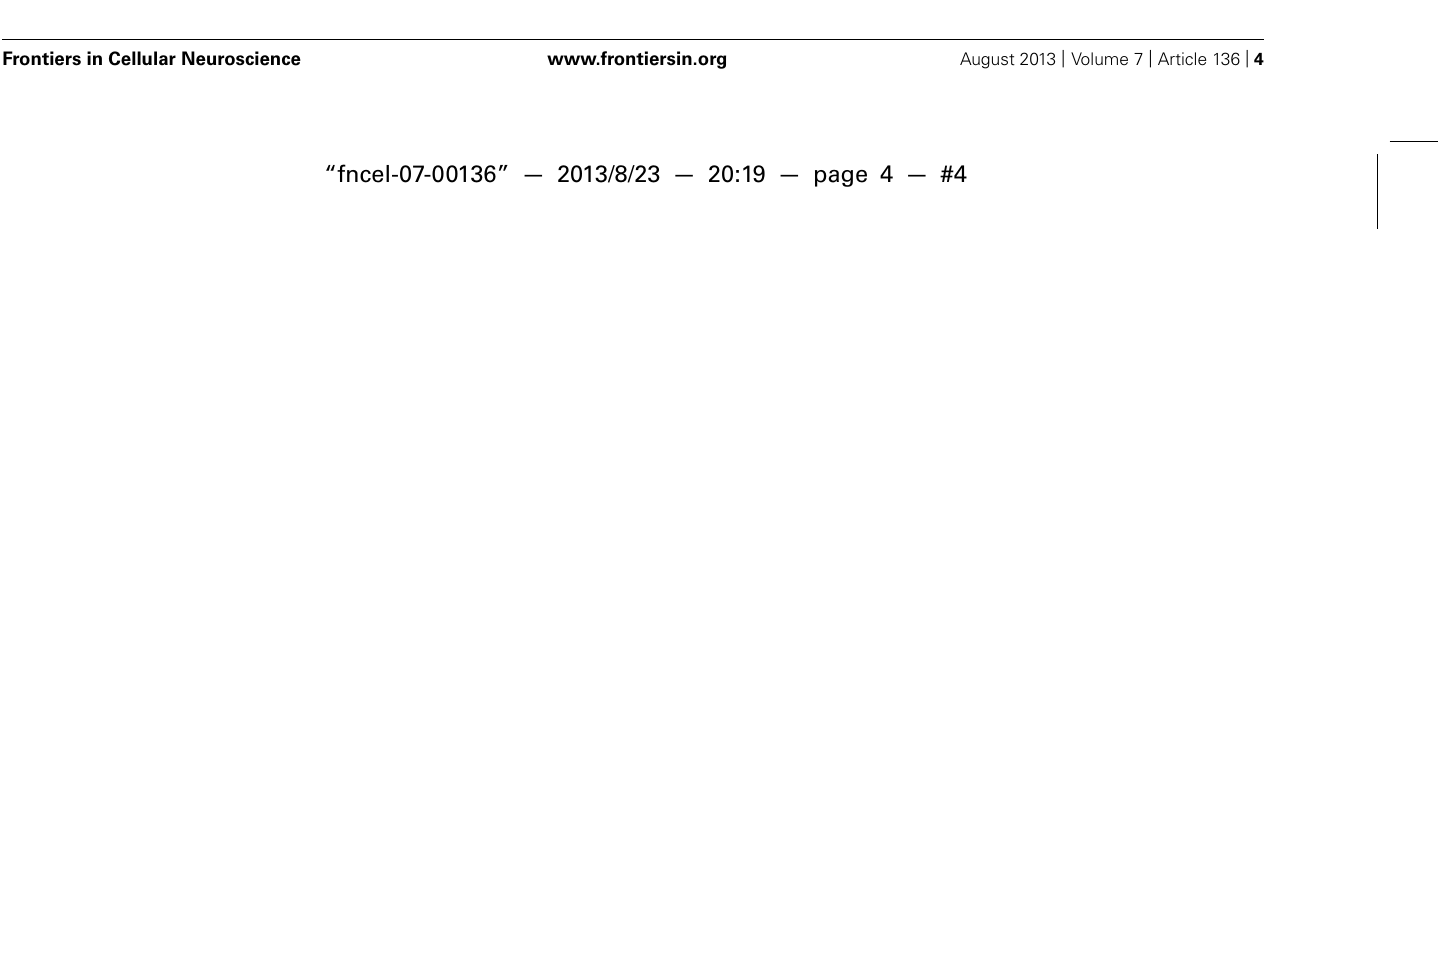
also promotes accelerated miRNA turnover through an additional unknown mechanism(s). Activity-dependent phosphorylation ofTRBP stabilizes Dicer, leading to increased mature miRNA production. NMDAR-activation promotes the ubiquitinylation of MOV10, a component of RISC, which may lead to decreased levels of mature-miRNA loaded RISC. See text for